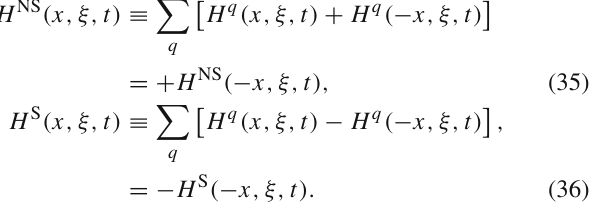
Fig. 9 Upper panel The sensitivity of H u to the variation of the α parameter in the case of SW predictions. Lower panel As in the upper panel for I R improved potential. See